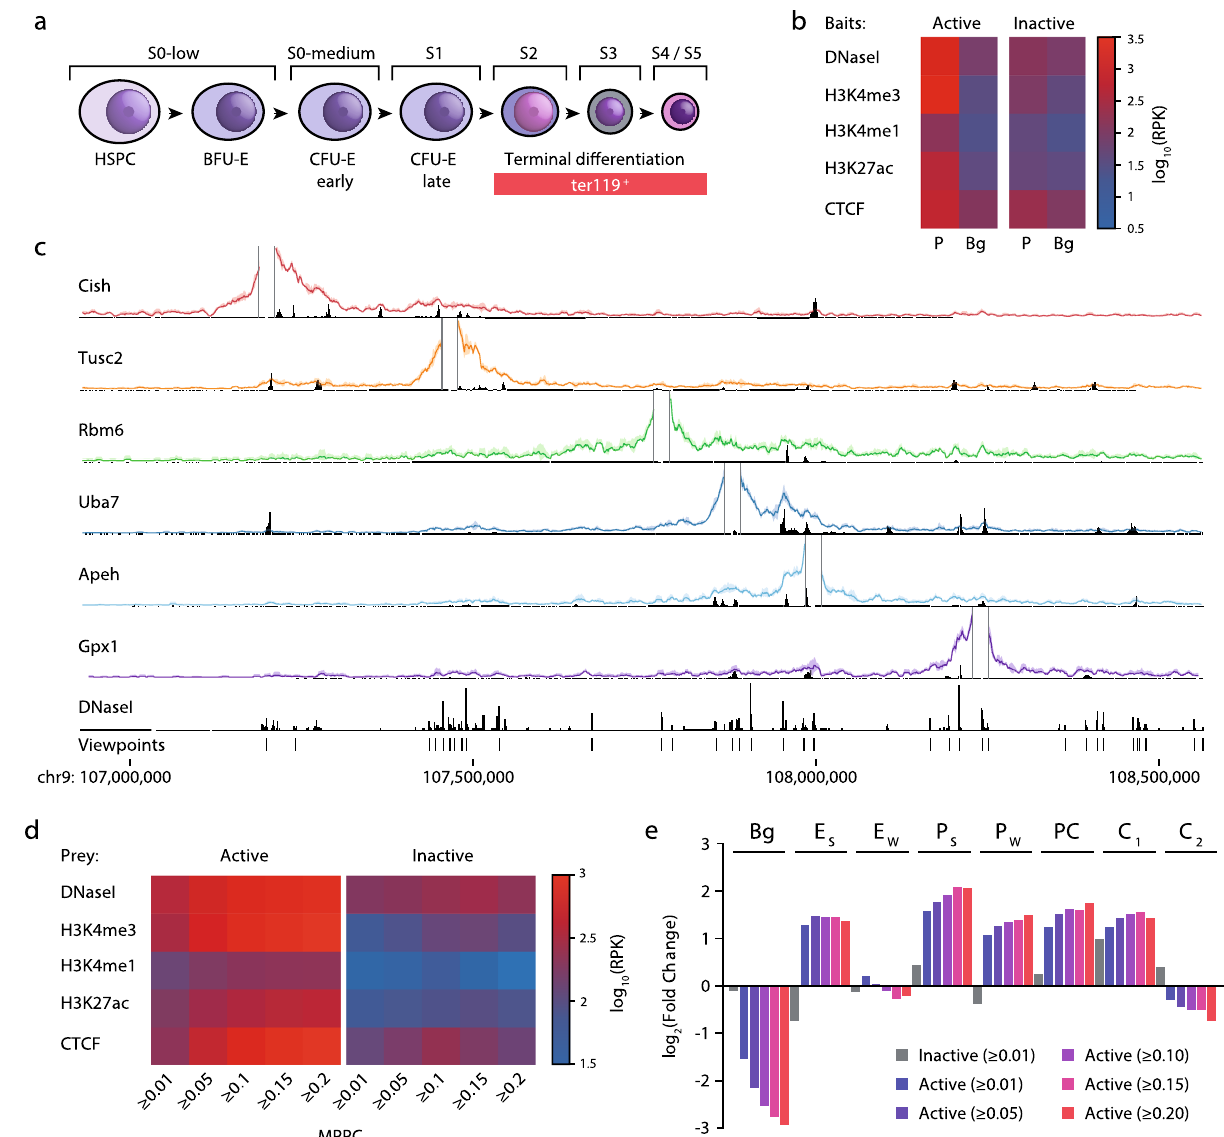
Fig. 3 Genome-wide high-resolution 3C in mouse erythroid cells. a Stages (S) of commited murine erythropoiesis with FACS-sorted populations including haematopoietic stem and progenitor cells (HSPC), erythroid blast forming units (BFU-E), and colony-forming units (CFU-E). b Average sequence coverage signature of promoter (P) containing fragments (±1 kb) classi fi ed as active ( n = 7014) or inactive ( n = 181) compared to an equivalent number of background regions (Bg). Chromatin marks from mouse erythroid cells show open chromatin (DNaseI), promoters (H3K4me3), active transcription (H3K27ac), enhancers (H3K4me1), and boundaries (CTCF). Background (Bg) signal was calculated by generating random peaks of the same number and size using BEDtools shuf fl e. RPK reads per kilobase. c Windowed mean 3C interactions ( n = 3 independent 3C libraries) over 1.5 Mb (mm9: chr9:106926158-108566246) for six NuTi Capture-C viewpoints with peaky Marginal Posterior Probability of Contact (MPPC) scores (black peaks) and open chromatin (DNaseI). d Average chromatin signal for interacting fragments (prey) of increasing MPPC identi fi ed by capturing either active or inactive promoters. e Enrichment of GenoSTAN annotations for interacting fragments with increasing MPPC. Bg: Background, E S : Enhancer (Strong H3K27ac), E W : Enhancer (Weak H3K27ac), P S : Promoter (Strong H3K27ac), P W : Promoter (Weak H3K27ac), PC: Promoter/CTCF, C 1 : CTCF near Promoter/Enhancer, C 2 : CTCF. Source data are available in the Source Data fi